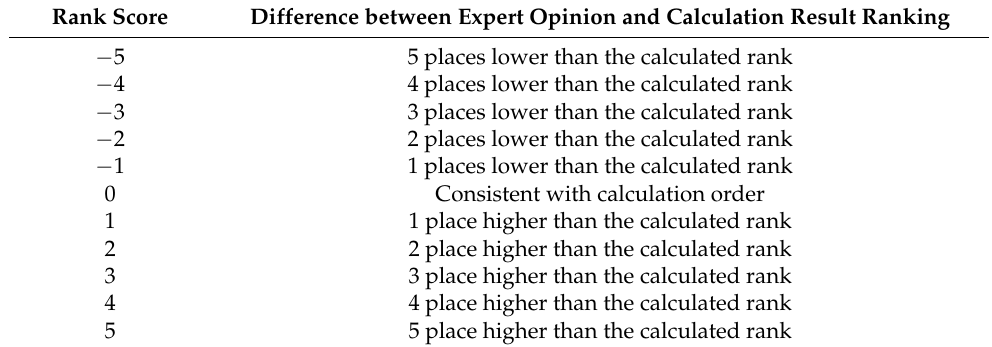
Table 7. Normal distribution test